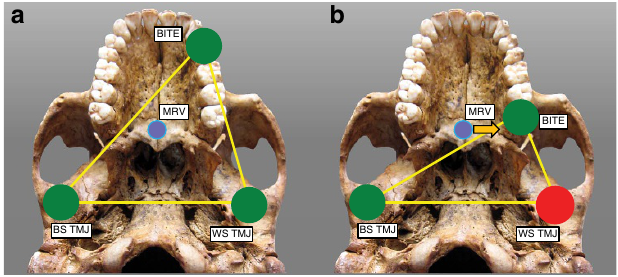
Figure 4 | The constrained lever model of jaw biomechanics. A‘triangle of support’ is formed by the bite point (BITE) and the working-side (WS) and balancing-side (BS) temporomandibular joints (TMJ). During a premolar